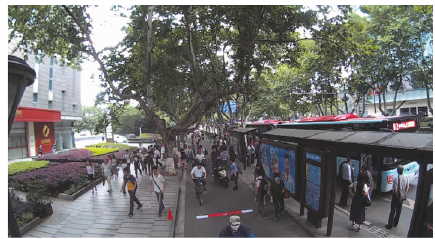
Figure 1: Effects of bus stop on bicycle traffic flow.